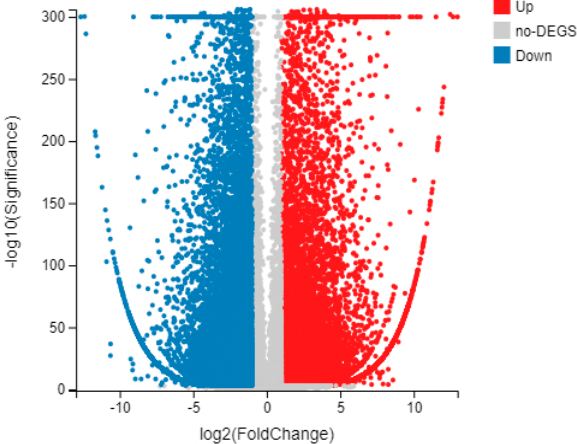
Figure 12. Volcanic map of inter-group differences. Each dot represents a gene, and the color is used to distinguish whether the gene is differential expressed. In the figure, the red dot represents the up-regulated differential expressed gene, the blue dot represents the down-regulated differential expressed gene, and the gray dot represents the non-differential expressed gene. For the Yunwu Tribute Tea, under cold stress, the expression levels of GPX , P5CS , and NCED were significantly up-regulated while those of PPO and G3O2 were signifi-